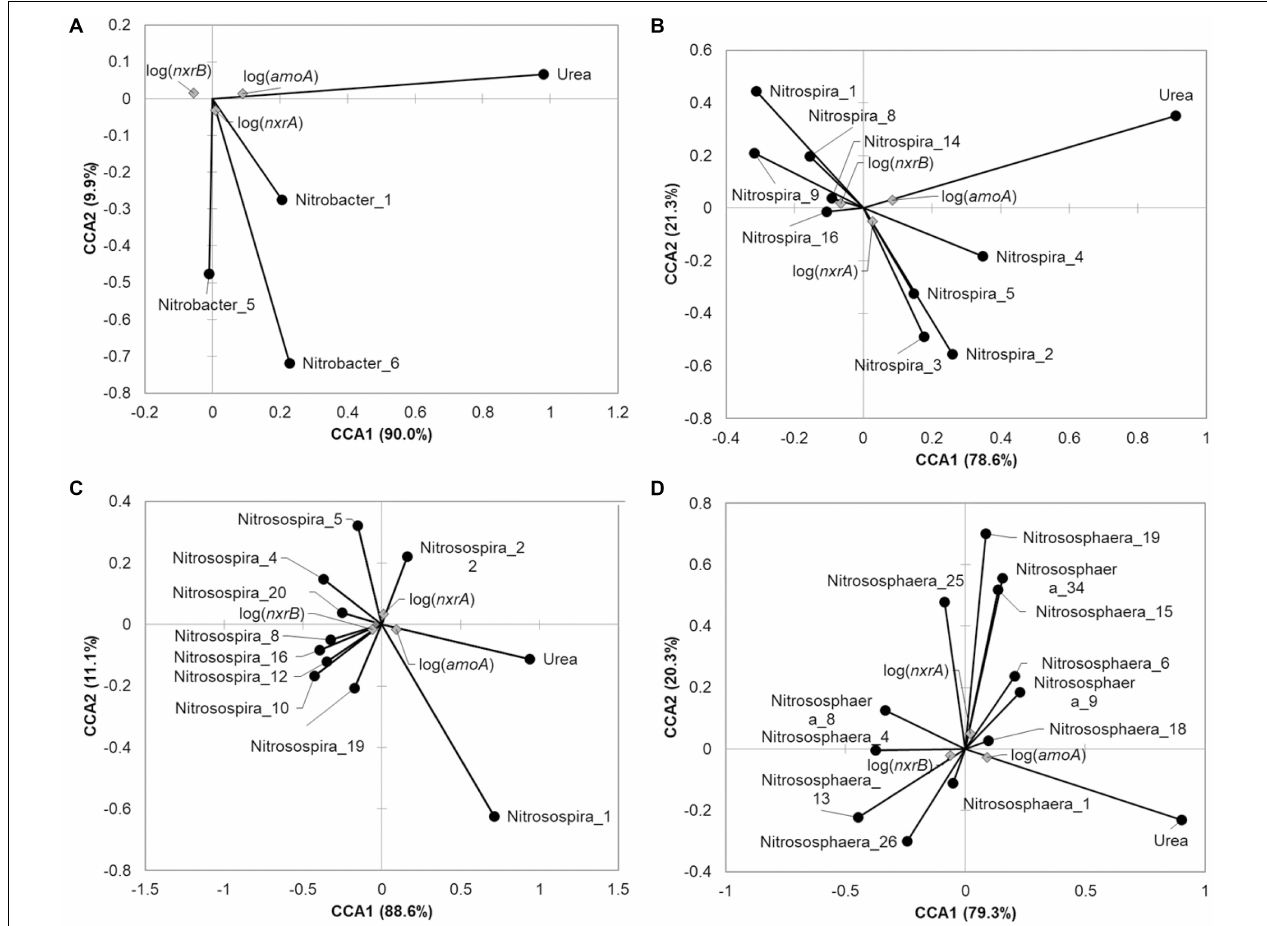
FIGURE 5 | Canonical correspondence analysis relating oligotypes and urea amendment concentration to abundance of nitrification genes at 21 days post-treatment. Relative abundance of the oligotype within the genus was used for analysis for (A) Nitrobacter , (B) Nitrospira , (C) Nitrosospira , or (D) Nitrososphaera. Only those oligotypes that showed significant Spearman correlations ( P < 0.05) with nitrification genes are shown. TABLE 3 | Mean abundances ( ± standard deviation, as %) of nitrifying prokaryotic taxa interrogated by oligotyping. Site Nitrosospira Nitrospira Nitrobacter Nitrososphaera Becker